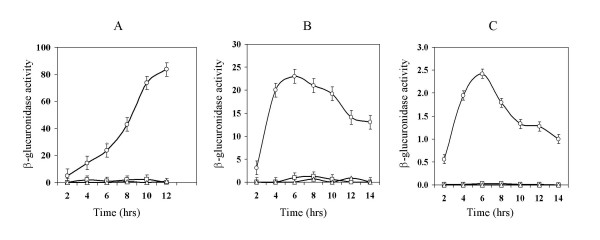
Expression of ssp1-gusA (A), ssp2-gusA (B) and ssp3-gusA (C) fusions in C. perfringens wild-type SM101 grown in vegetative (□) and sporulation (○) medium, and in spo0A mutant IH101 grown in sporulation medium (Δ). β-glucuronidase activity (in Miller Units) was calculated as previously described [26, 28]. Data represents the average of three independent experiments.